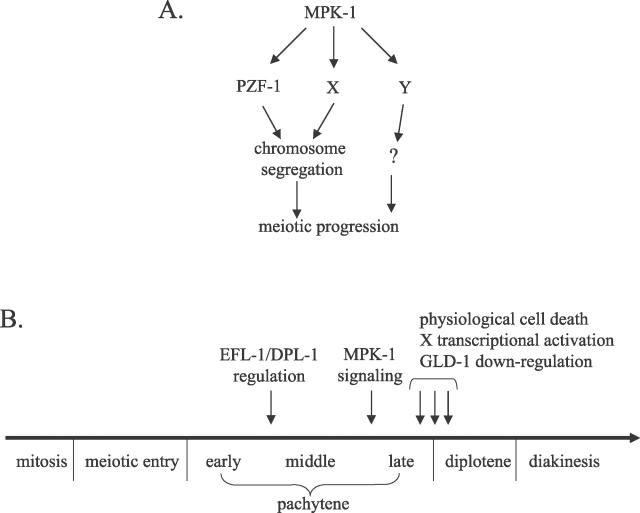
MPK-1 Signaling in the Germ Line(A) Model of multiple MPK-1 signaling-dependent effectors acting together to promote meiotic progression. X and Y represent putative proteins that function downstream of MPK-1. Additional processes besides chromosome segregation that contribute to meiotic progression are indicated by the question mark.(B) Representation of events in germ line development. MPK-1 signaling occurs downstream of EFL-1/DPL-1 gene regulation, but prior to physiological germ cell death, X chromosome transcriptional activation, and GLD-1 down-regulation.